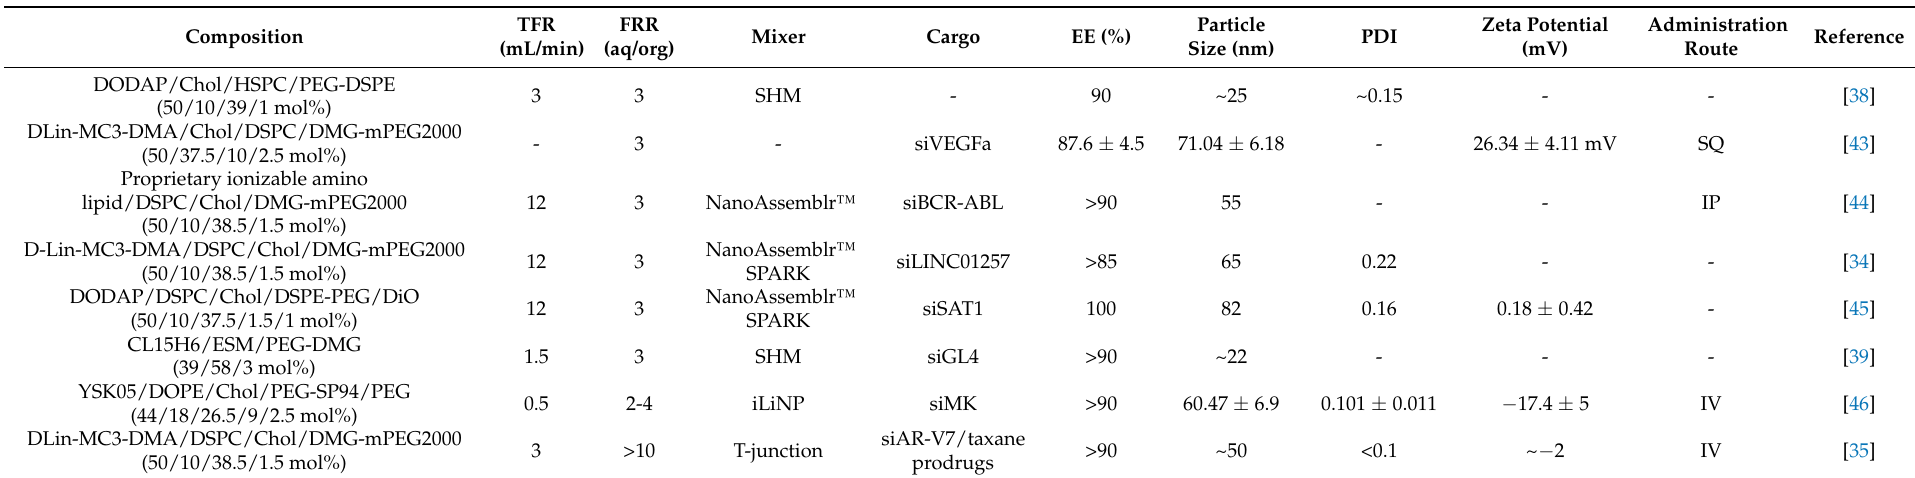
Table 2. siRNA LNPs for drug delivery and their physicochemical